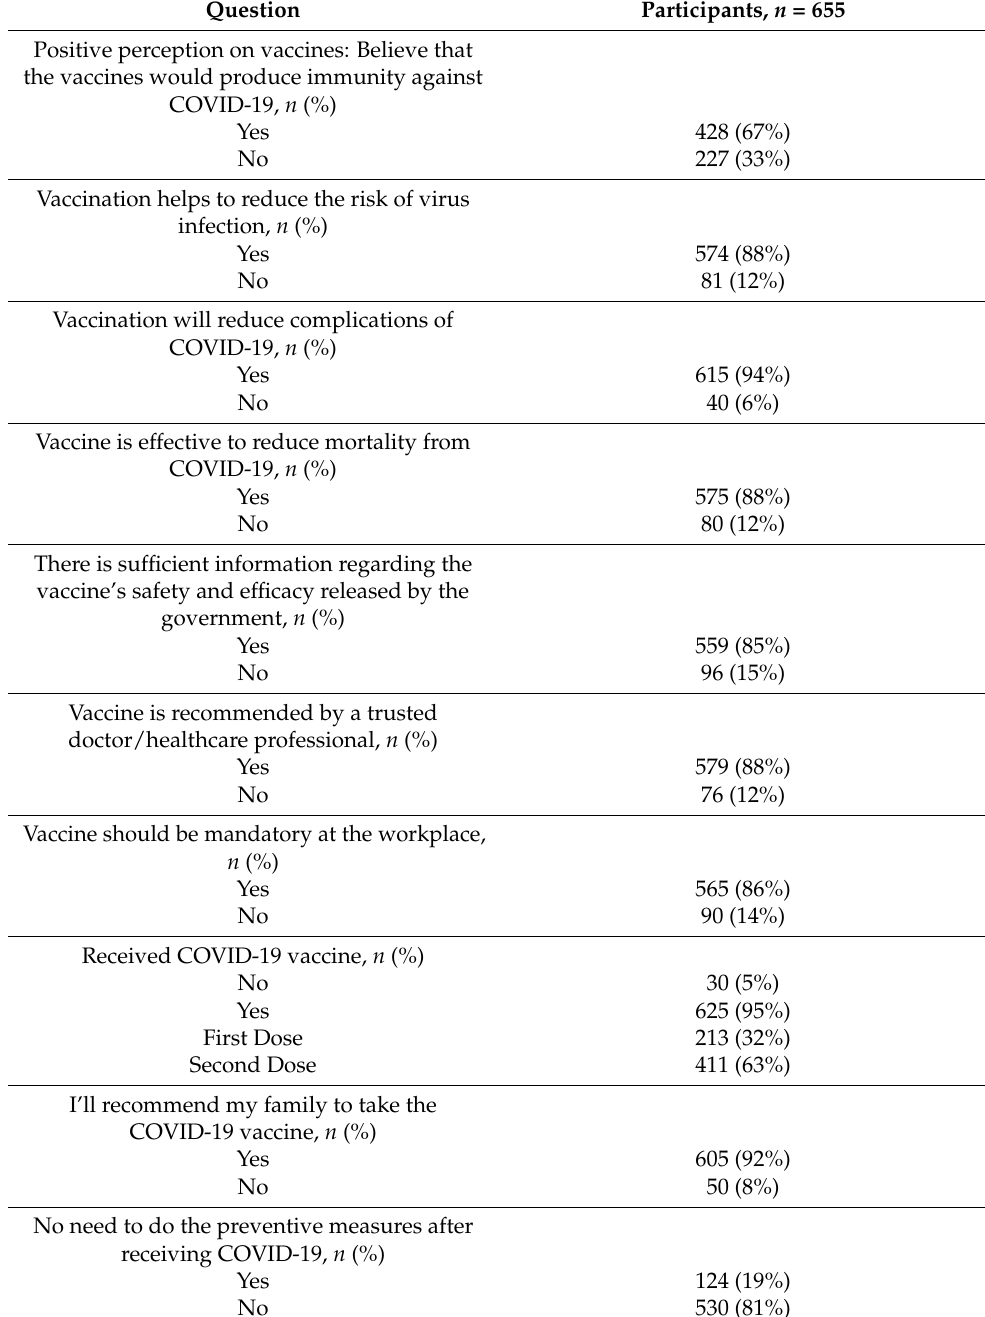
Table 2. Knowledge and practice of the study participants toward COVID-19